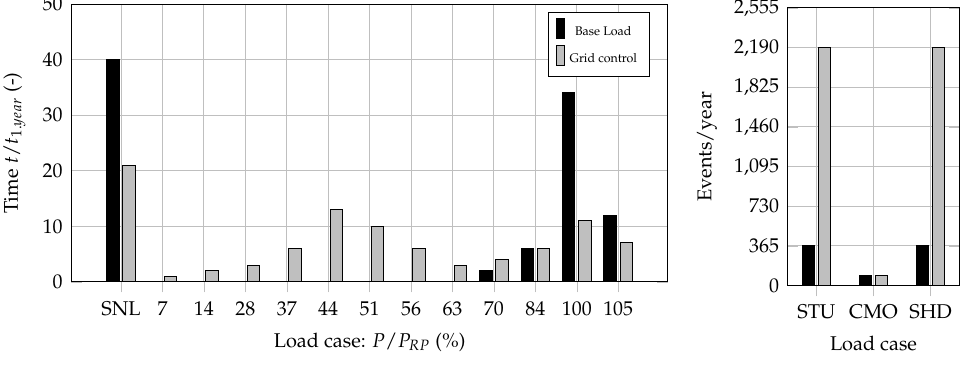
Figure 5. Operating time for different load regimes in 1 year. Adapted from